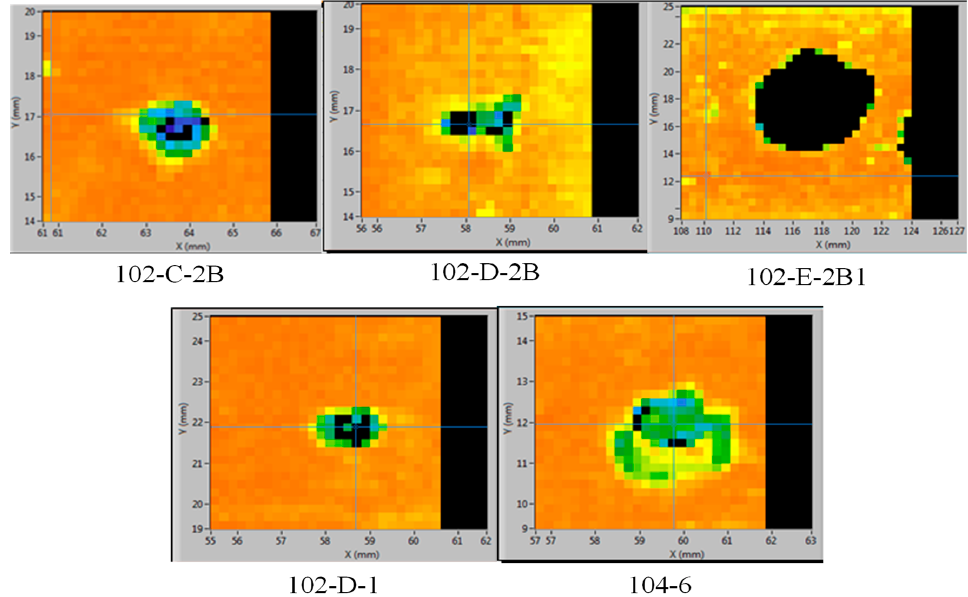
Figure 11 . Representative images of the colorized debond locations caused by laser shock testing in PNNL plates are shown. Note: The images are not to scale.